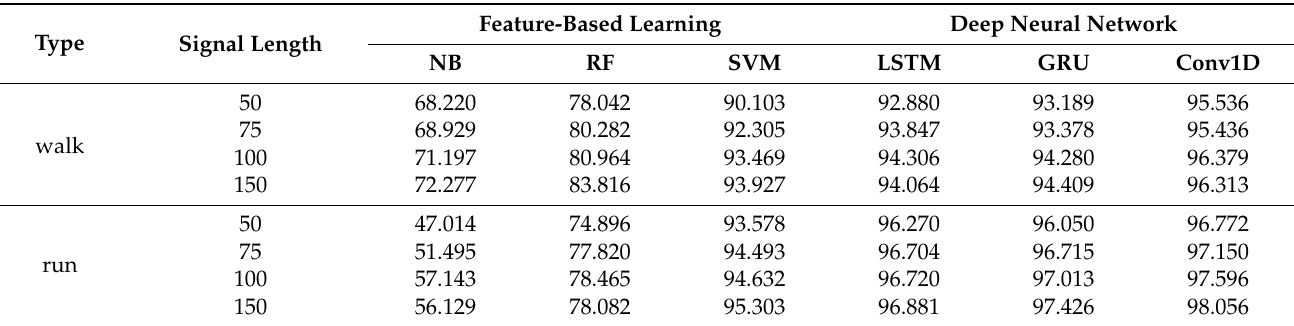
Table 4. Experimental results of test F m .